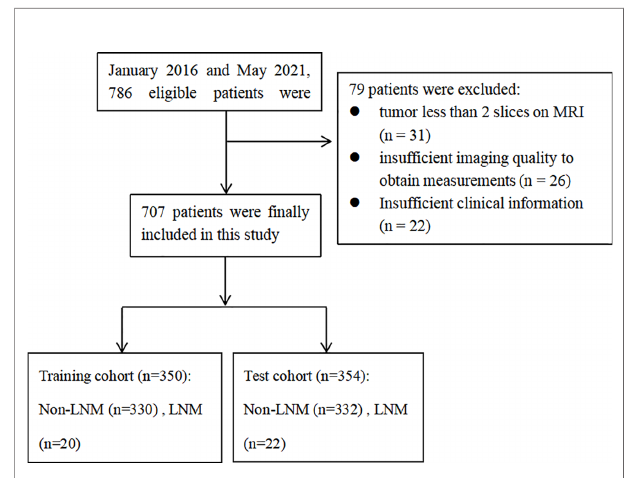
FIGURE 1 | The work fl ow of this